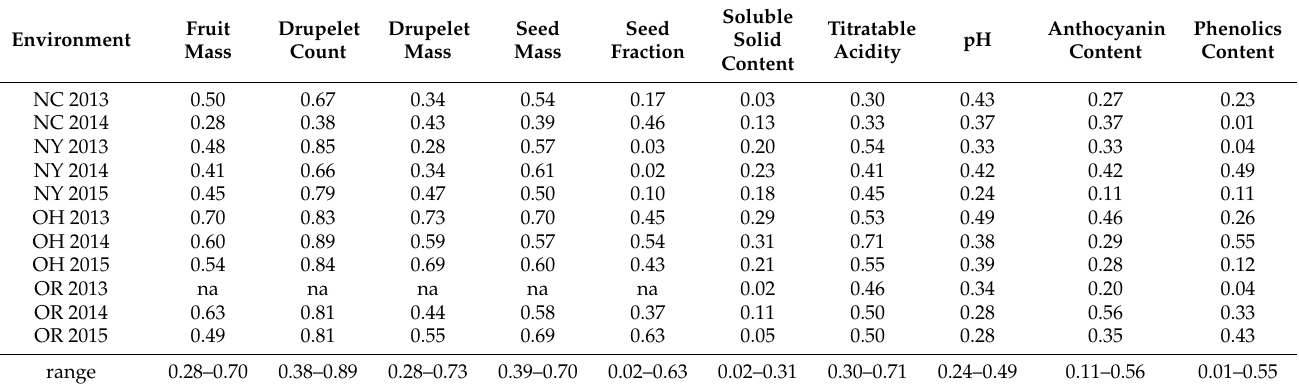
Table 4. Heritability values for each trait by environment, estimated by the best-fitting model for each trait. Environments correspond to locations (NC, NY, OH, and OR) and three years (2013, 2014, and